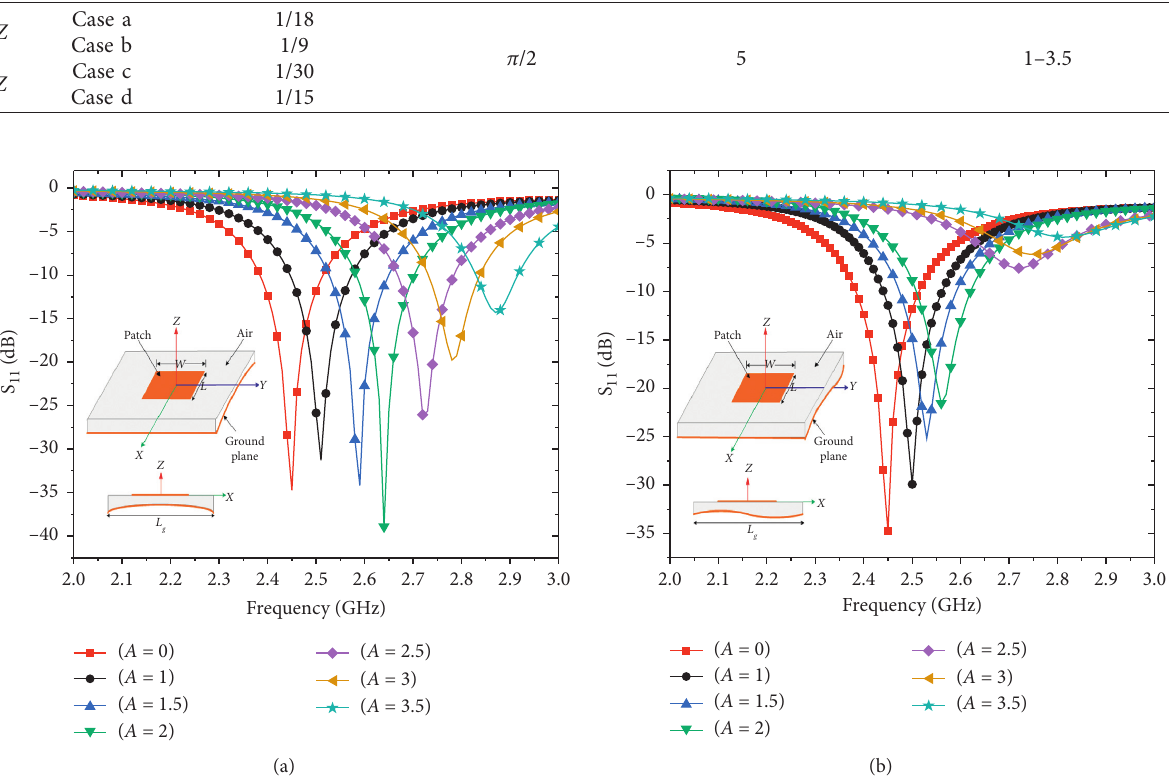
Figure 3: Ground plane deformation diagram. The (a) three-dimensional diagram, (b) XOZ plane deformation, and (c) YOZ plane deformation. Table 2: Parameters of sinusoidal curve with four different ground plane deformations. Deformation cases